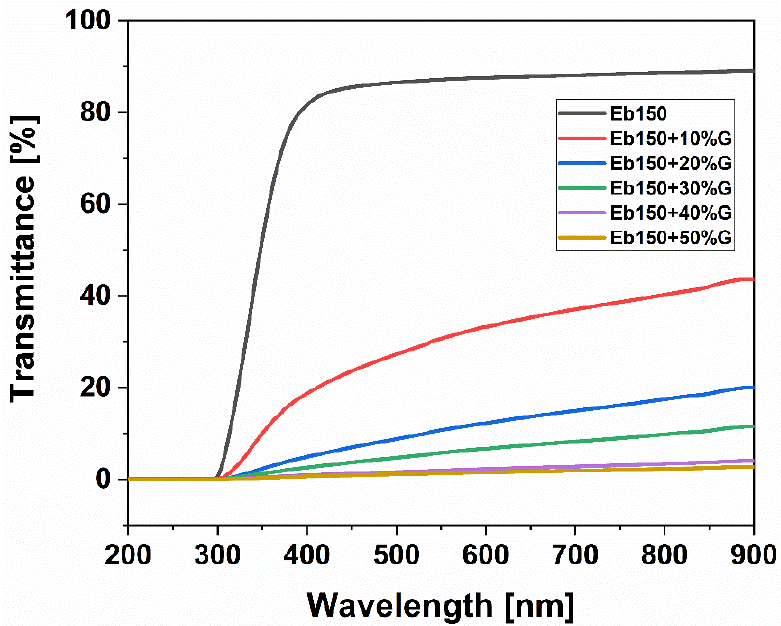
Figure 7. Pictures of UV-LED cured films prepared with different loadings of phosphate glass par- ticles.